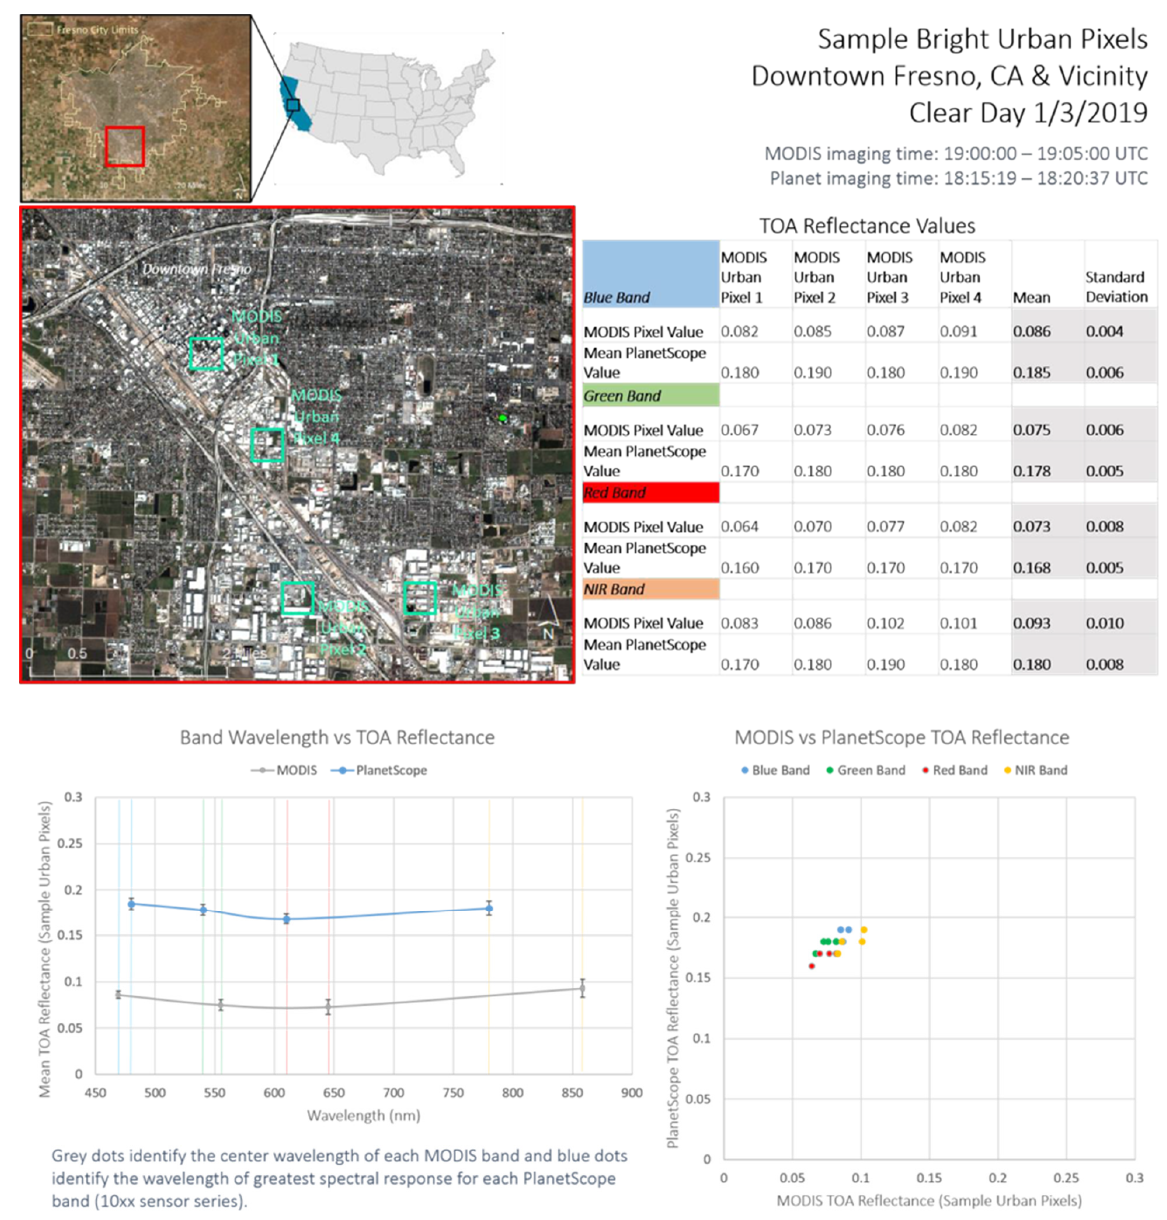
Figure A1. Results from Section 3.2 for pixels sampled over an urban area with light colored and/or highly reflective buildings in the Fresno study area on 1/3/2019.